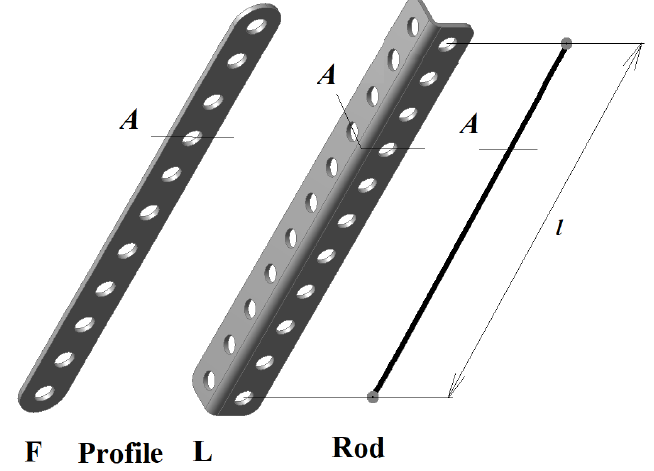
Figure 5. Basic parts for design of